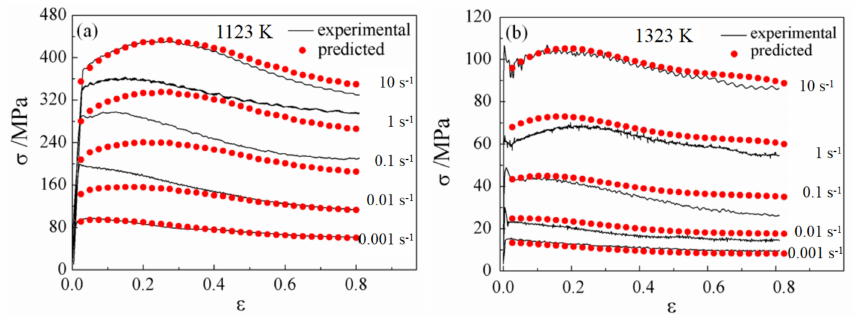
Figure 14. Comparison of the theoretical and the predicted values of Ti-6.5Al-3.5Mo-1.5Zr-0.3Si titanium alloy at ( a ) 1123 K and ( b ) 1323 K.